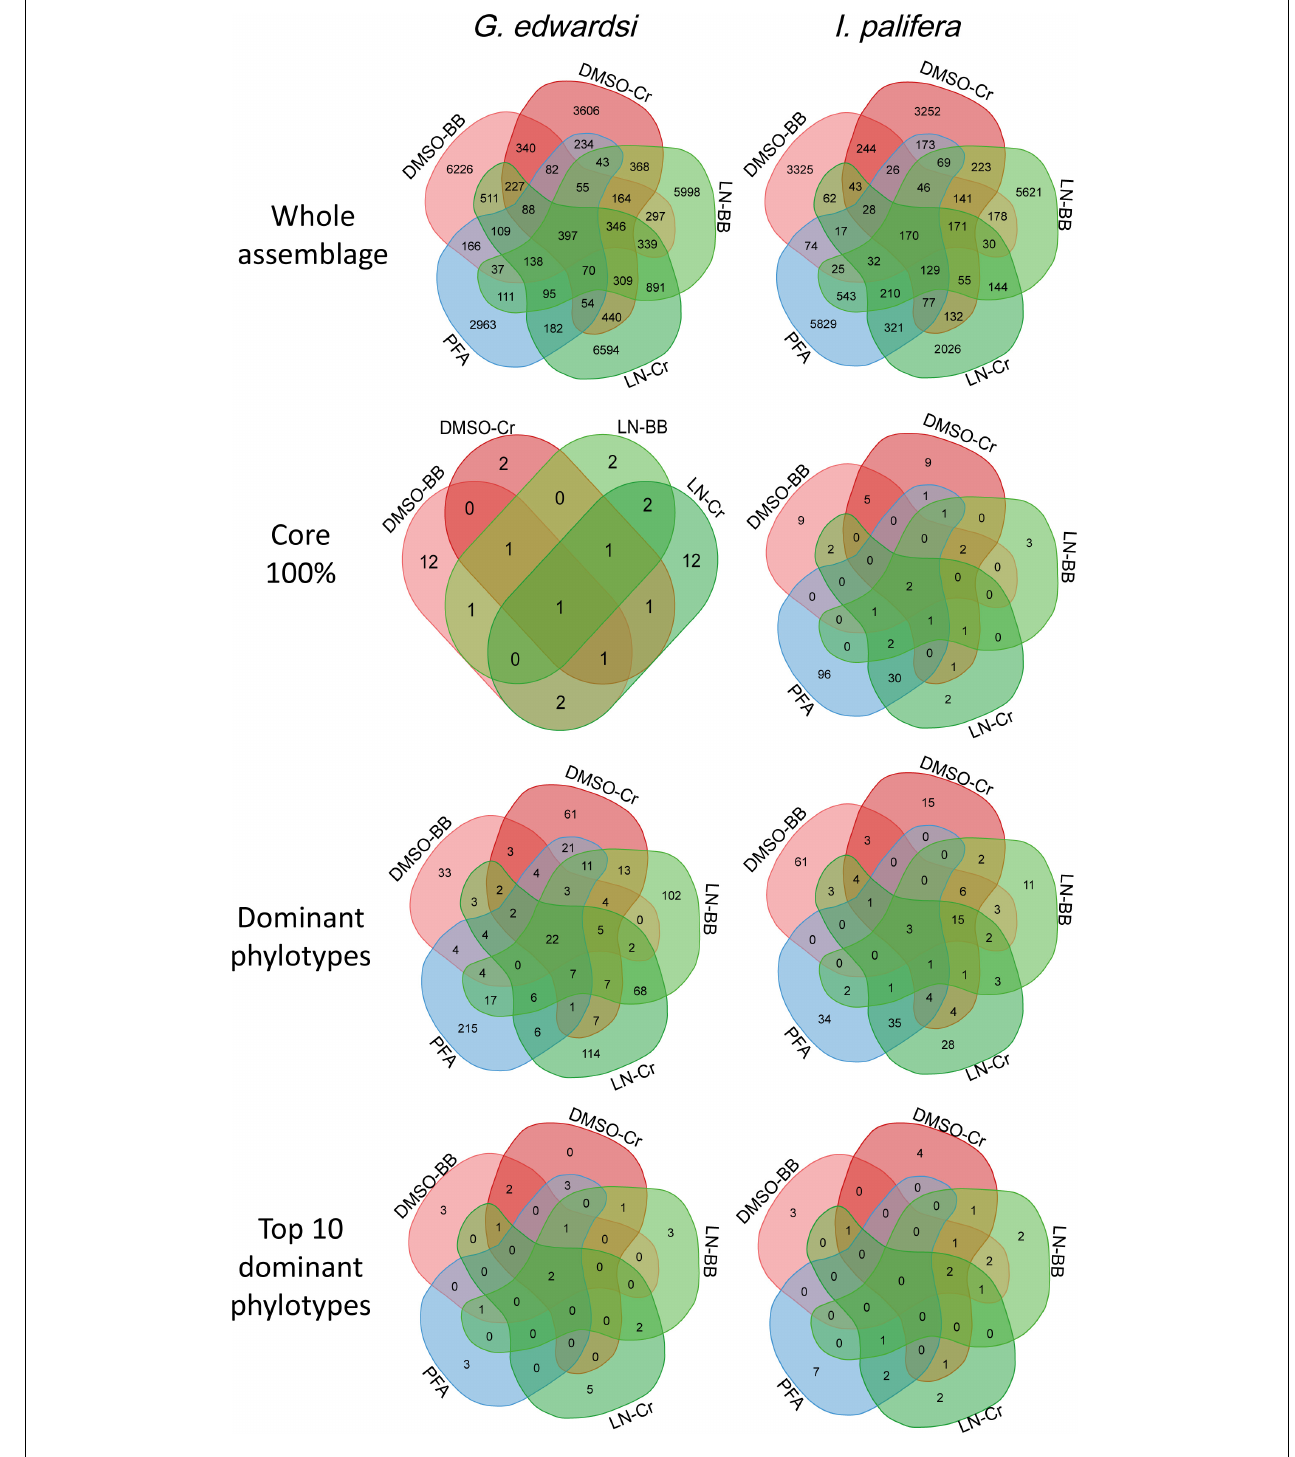
FIGURE 5 | Venn diagrams for the whole bacterial community, core 100%, dominant phylotypes and top 10 dominant phylotypes. Venn diagrams reflect that approximately 39 and 45% of OTUs of the whole bacterial assemblages in G. edwardsi and I. palifera are shared among methodologies. However, shared bacterial phylotypes are not consistently present as core microbiome, dominant or among the top 10 dominant OTUs across methodologies. Conversely, the ‘importance’ of bacterial phylotype, expressed as occurrence or relative abundance, varies among preservation and homogenization methods ( Supplementary Figures 3 , 4 and Supplementary Table 13 ). For OTUs taxonomic identification in core 100%, dominant phylotypes and top 10 dominant phylotypes see Supplementary Tables 14 , 15 .